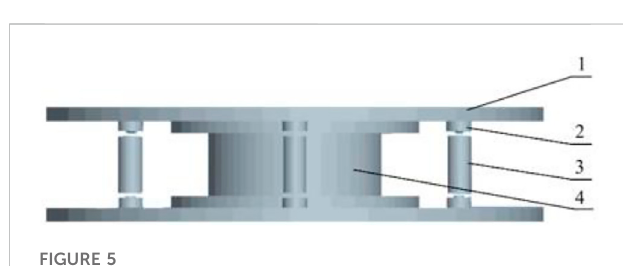
FIGURE 5 The schematic diagram of damping vibration isolation